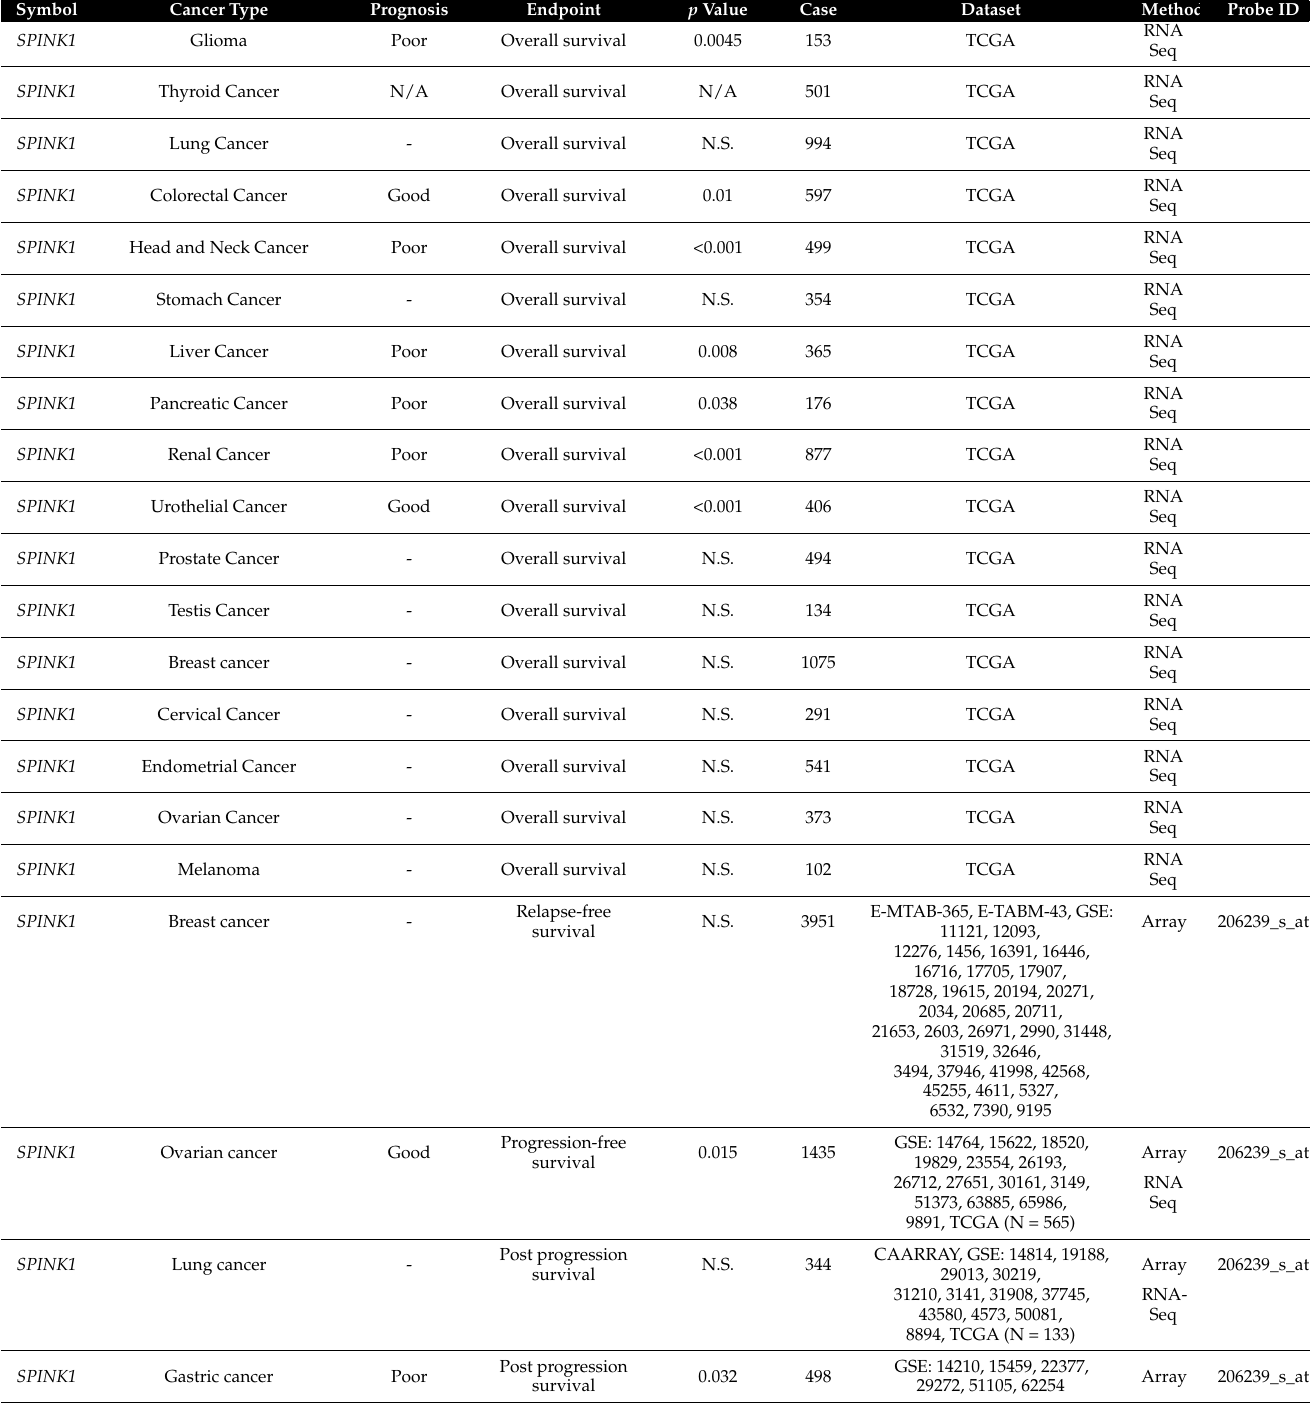
Table 1. Correlation of SPINK1 with cancer patient